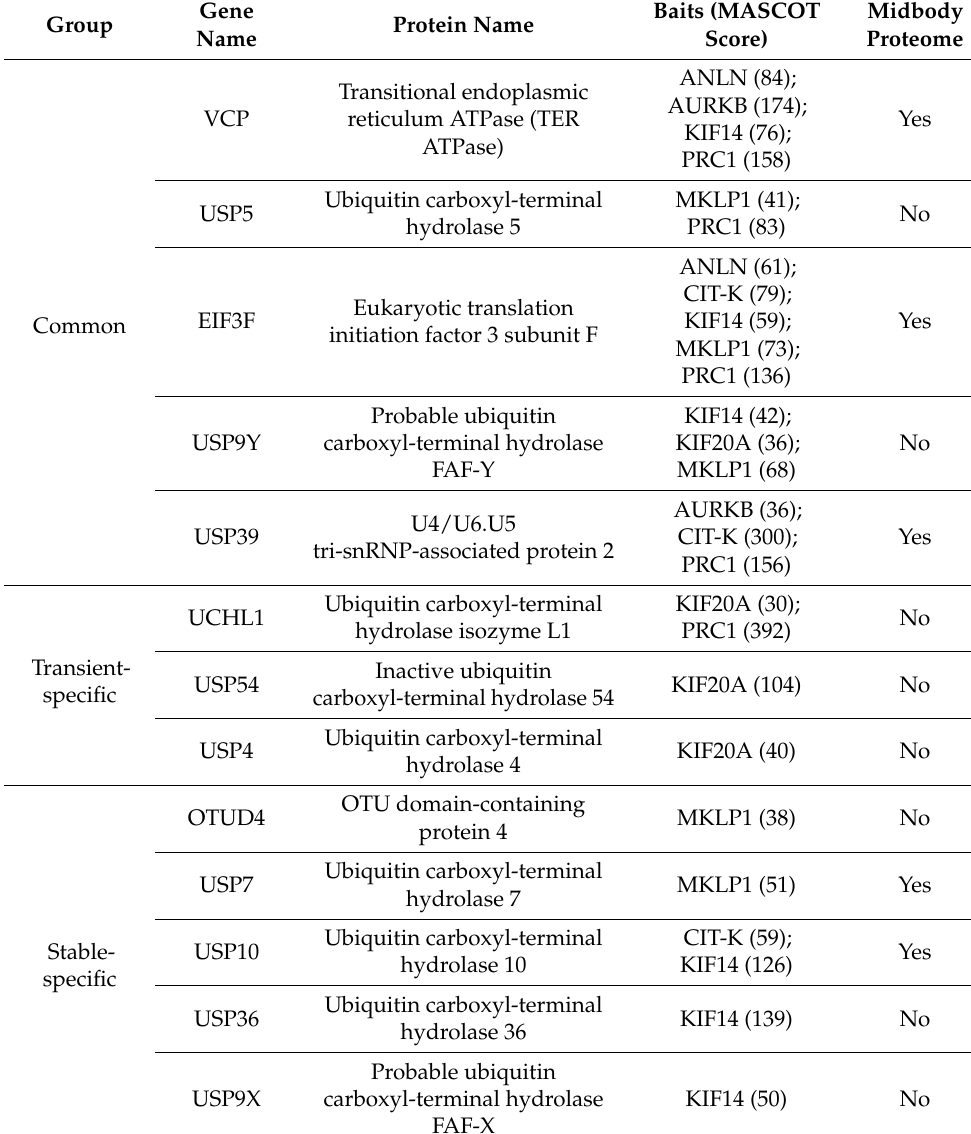
Table 1. List of deubiquitinases (DUB) identified in the midbody ubiquitylation interactome. Group